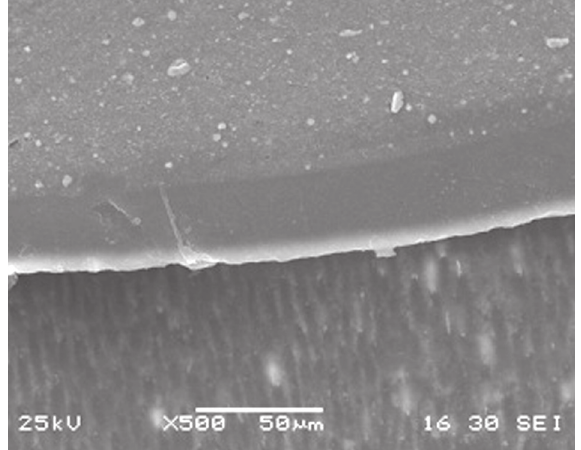
Figure 6- Photomicrograph of vestibular surface of Class I cavity preparation restored with P90/ Silorane Adhesive System